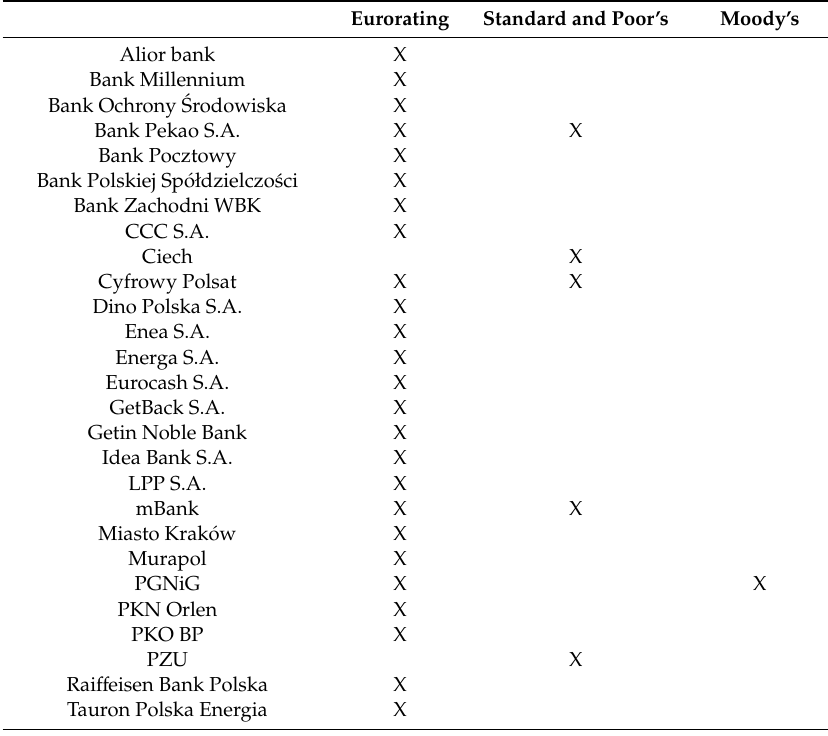
Table A1. Rating of corporate bonds in